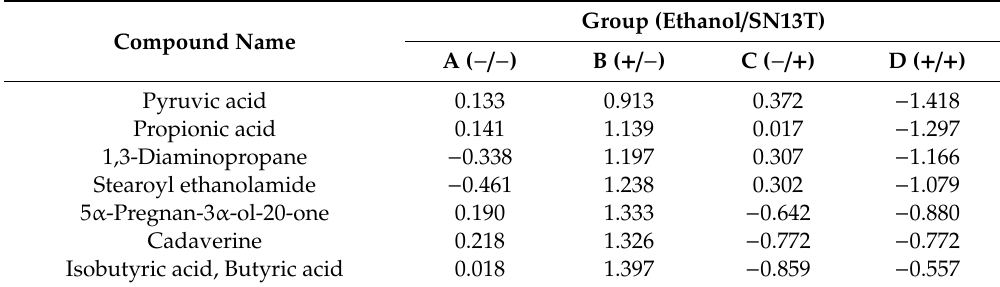
Figure 5. The hierarchical cluster analysis (HCA) of the mouse cecum metabolites. Denser green and red indicate low and high concentrations of metabolites, respectively. The dendrogram depicts the unweighted pair-group method of analysis (UGPMA) based on a standardized relative area of detected compounds. The experimental content of each group is the same as that in Figure 3. Table 2. Di ff erences of standardized relative area in metabolites in the cecum samples isolated from each mice